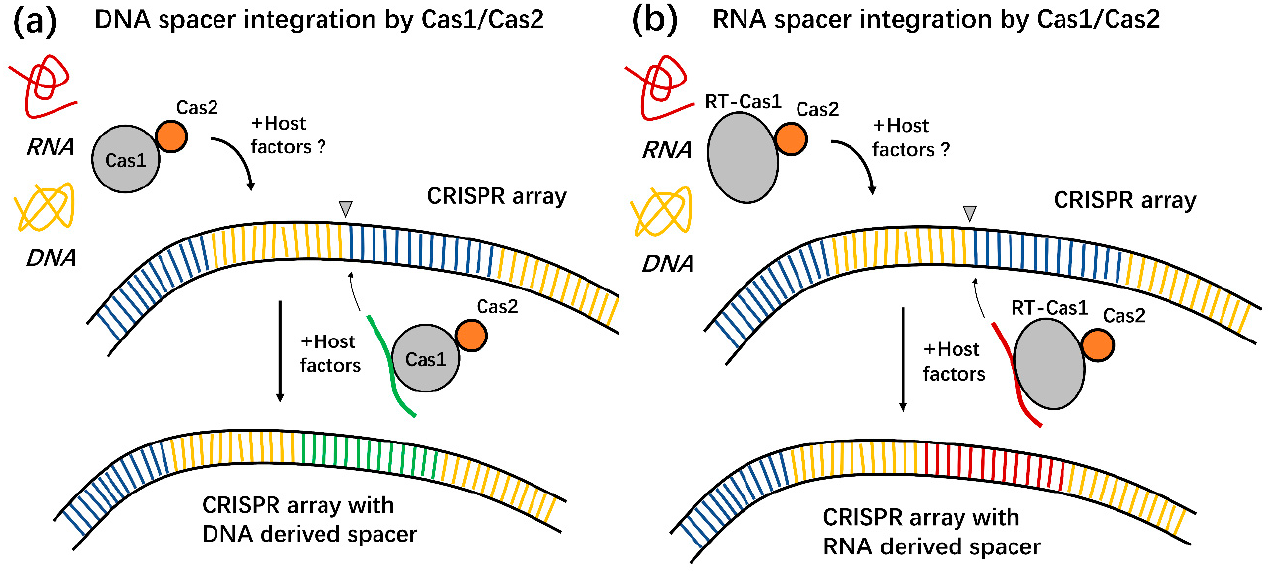
Figure 3. Schematic diagram of DNA and RNA spacers acquisition by CRISPR-Cas systems. ( a ) Small segments of invasive DNA are assimilated into CRISPR arrays by Cas1 and Cas2 in a canonical spacer acquisition process that allows adaptive immunity in a wide variety of bacteria and archaea. ( b ) In the type VI CRISPR systems, an RT fused to Cas1 enables the acquisition of spacer sequences directly from RNA. This process can mediate adaptive immunity against RNA-based parasites [40].